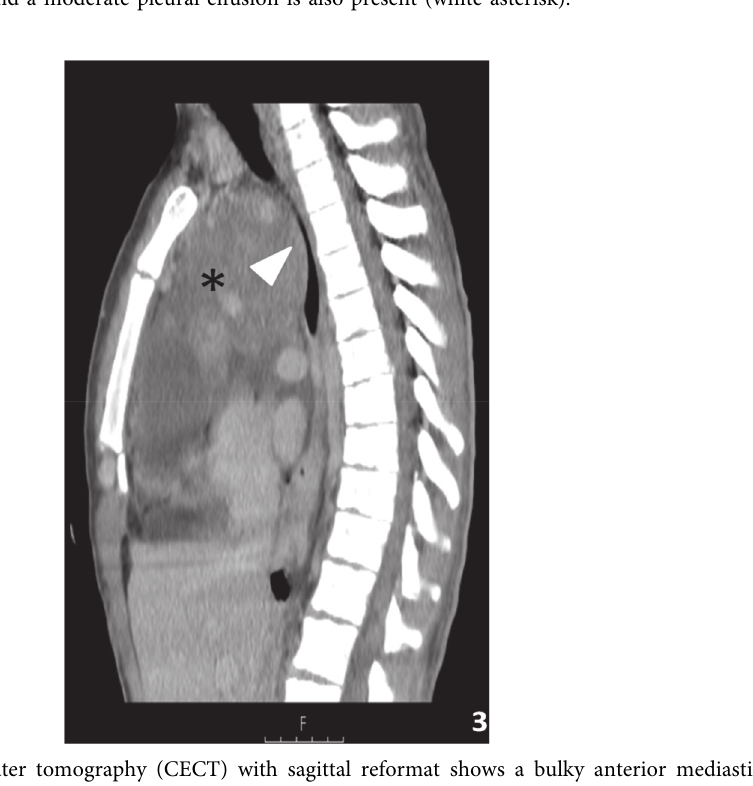
Figure 2: Contrast-enhanced computer tomography (CECT) with coronal reformat shows a bulky anterior mediastinal mass (black asterisk) encasing and compressing the superior vena cava (white arrow), resulting in superior vena cava syndrome. The mass also deviates from the aortic arch (black arrow), and a moderate pleural effusion is also present (white asterisk).